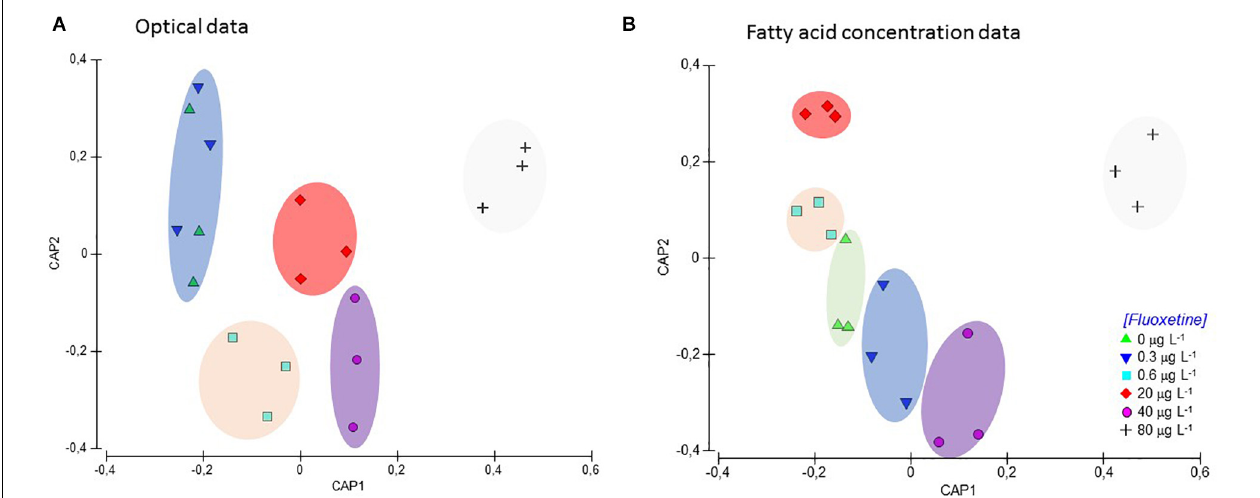
FIGURE 9 | Plots of canonical analysis of principle coordinates (CAP) based on optical data (values for each point of the Kautsky curve), (A) and fatty acid profiles (relative abundance of each fatty acid detected). (B) of Phaeodactylum tricornutum exposed to different fluoxetine concentrations for 48 h. Ellipses group samples with lower statistical distance.